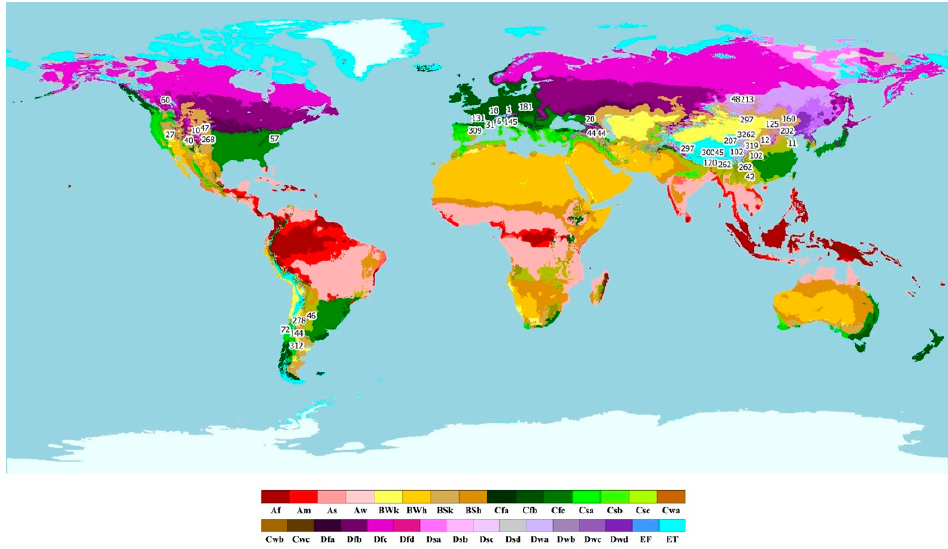
Figure 5. Köppen–Geiger climate map showing study site locations from articles included in the meta-analysis. Numbers correspond to article numbers. Colour scale refers to Köppen–Geiger